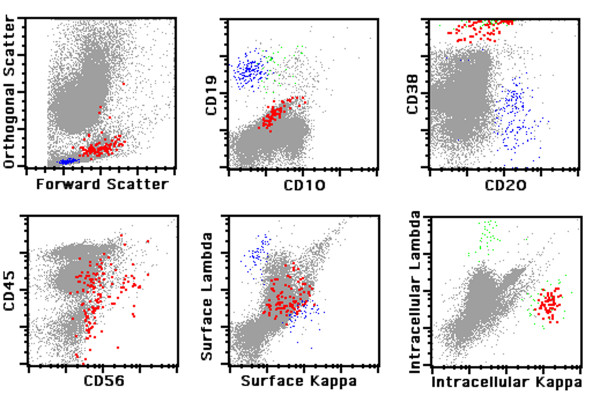
Immunophenotypic analysis of monoclonal gammopathy of undetermined significance. Highlighted in red are neoplastic plasma cells; mature B lymphocytes are painted in blue and polytypic plasma cells in green.